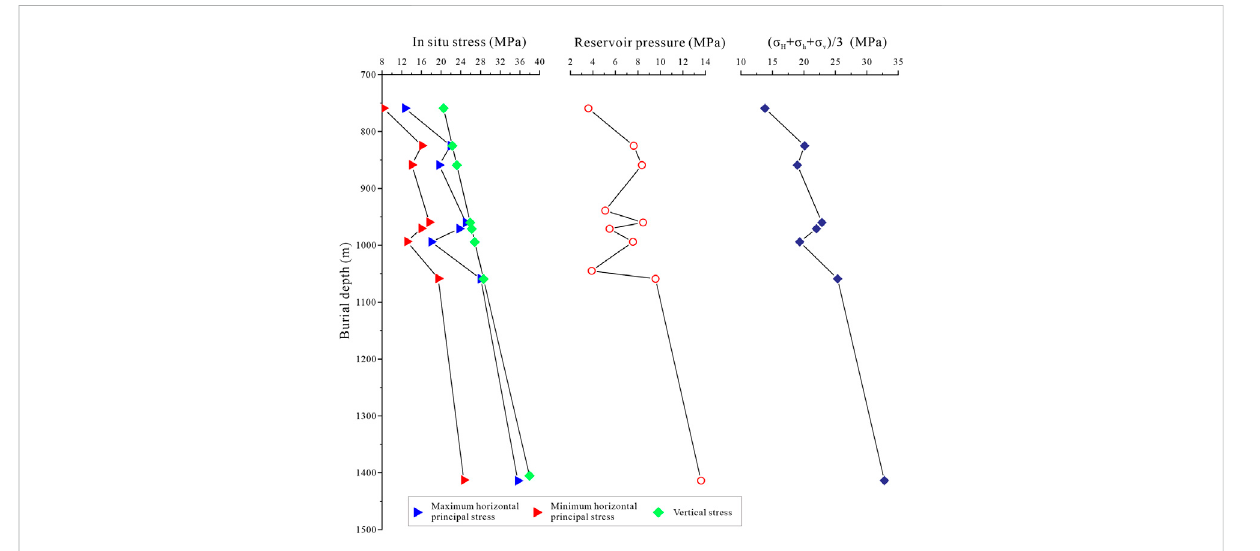
FIGURE 7 Variation of in-situ stresses, reservoir pressure and average total stress with